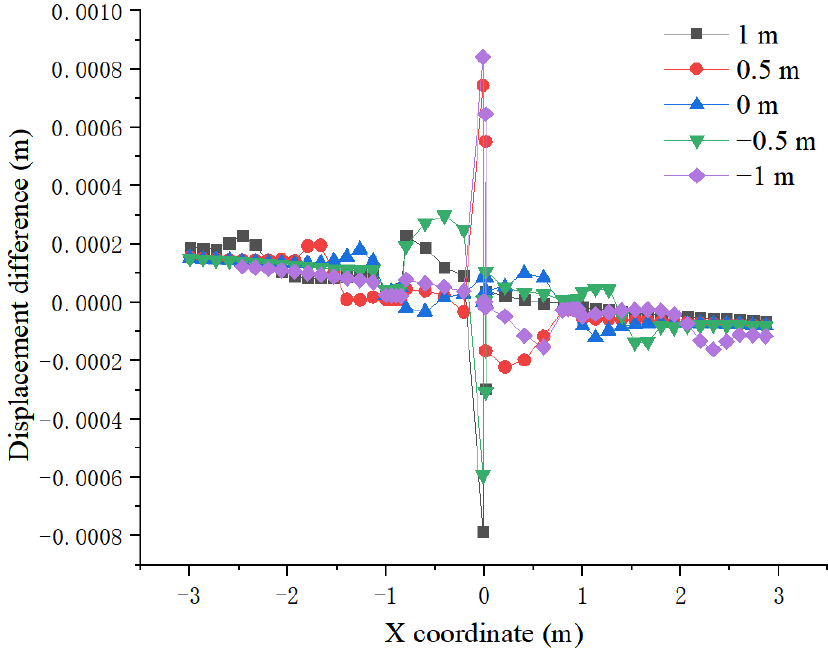
Figure 27. Distribution of displacement difference at 14.625 m under different load positions.